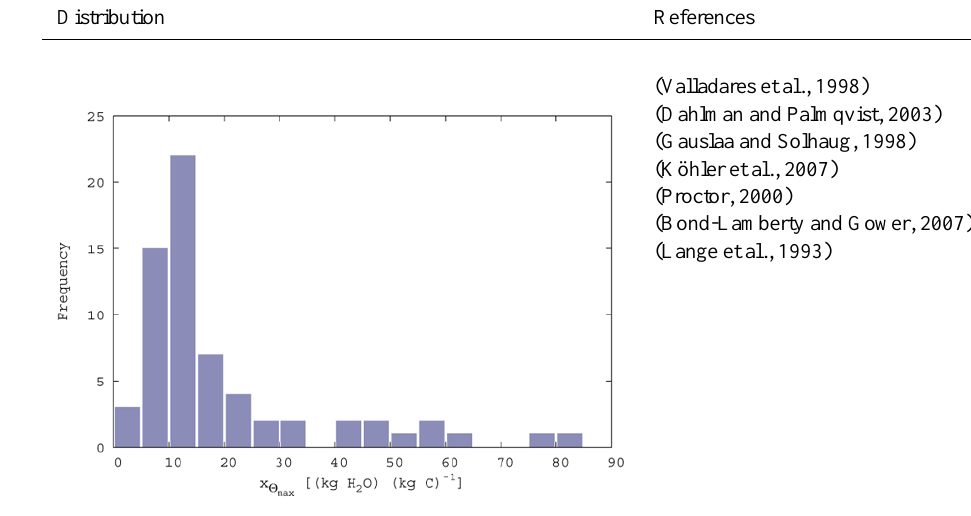
Fig. B1. Overview of the distribution of specific water storage capacity x 2